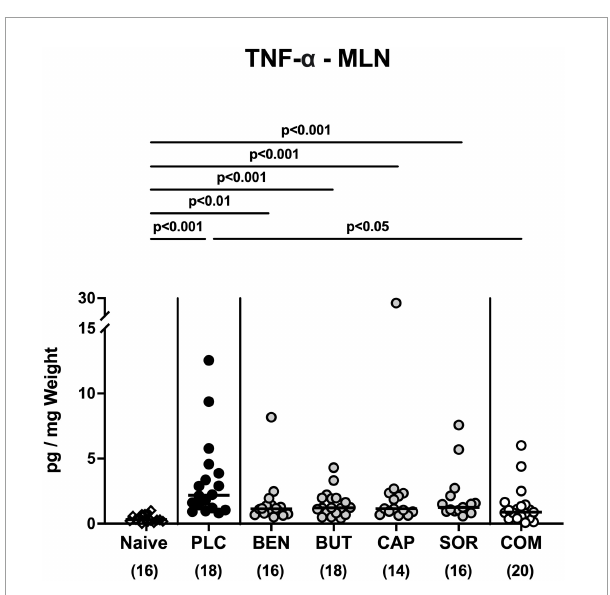
FIGURE7 Pro-inflammatory mediator secretion in mesenteric lymph nodes upon single and combined organic acid treatment. Infected mice were perorally treated with benzoic acid (BEN), butyric acid (BUT), caprylic acid (CAP), sorbic acid (SOR), or a combination of all acids (COM). The placebo (PLC) group only received autoclaved tap water. On day 6 post-infection, TNF- α concentrations were assessed in supernatants of ex vivo biopsies derived from the mesenteric lymph nodes (MLN). Medians (black bars), significance levels ( p values) calculated by the ANOVA test with Tukey’s post-correction or by the Kruskal-Wallis test and Dunn’s post-correction, and the total mice numbers (in parentheses) are given. Data were pooled from three independent